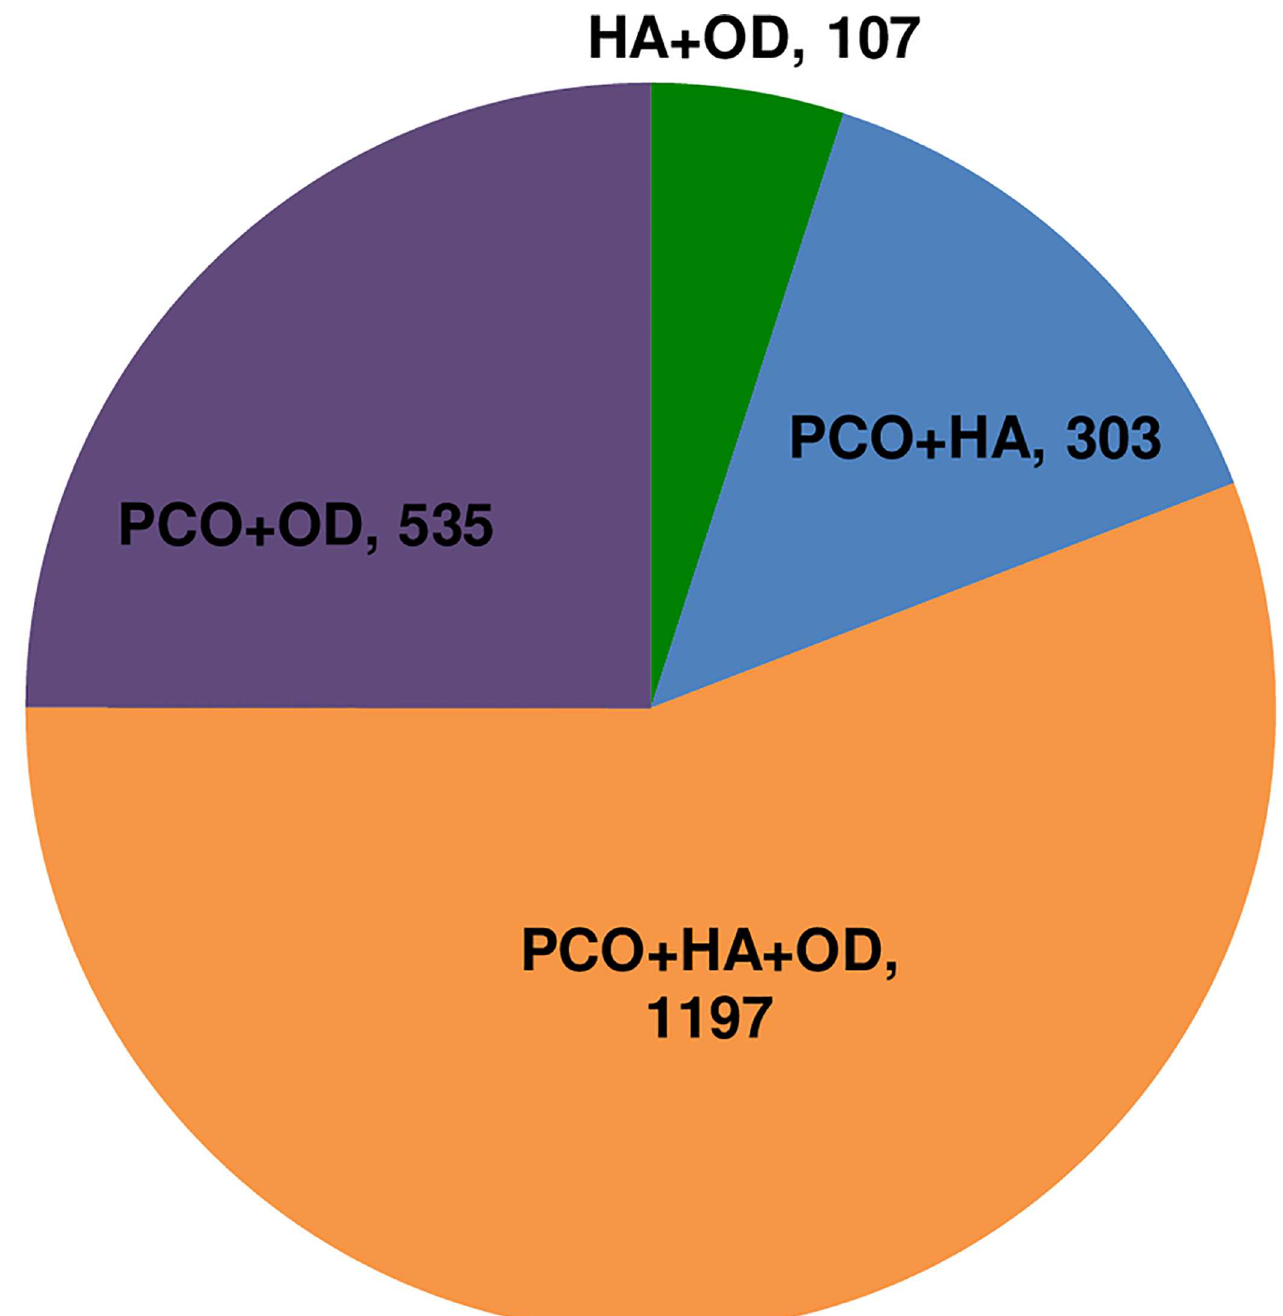
Fig 1. Distribution of PCOS Phenotypes in Female Participants ( (cid:21) 18 years of age). [PCO+HA+OD is the classic reproductive phenotype which has polycystic ovary morphology, androgenexcess and ovulationdysfunction. PCO+HA is the ovulatoryphenotypewhich has polycystic ovary morphologyand androgenexcess with ovulation.HA+OD is the phenotypewhich has androgenexcess and ovulationdysfunction without polycystic ovary morphology.PCO+OD is the phenotype which has polycystic ovary morphology and ovulationdysfunctionwithout androgen excess. Among 2436 youngadults with PCOS ( (cid:21) 18 years of age), (1197/1981) were PCO+HA+OD, (303/2215)were PCO+HA, (107/2116)were HA+OD, and (535/1997)were PCO+OD.]